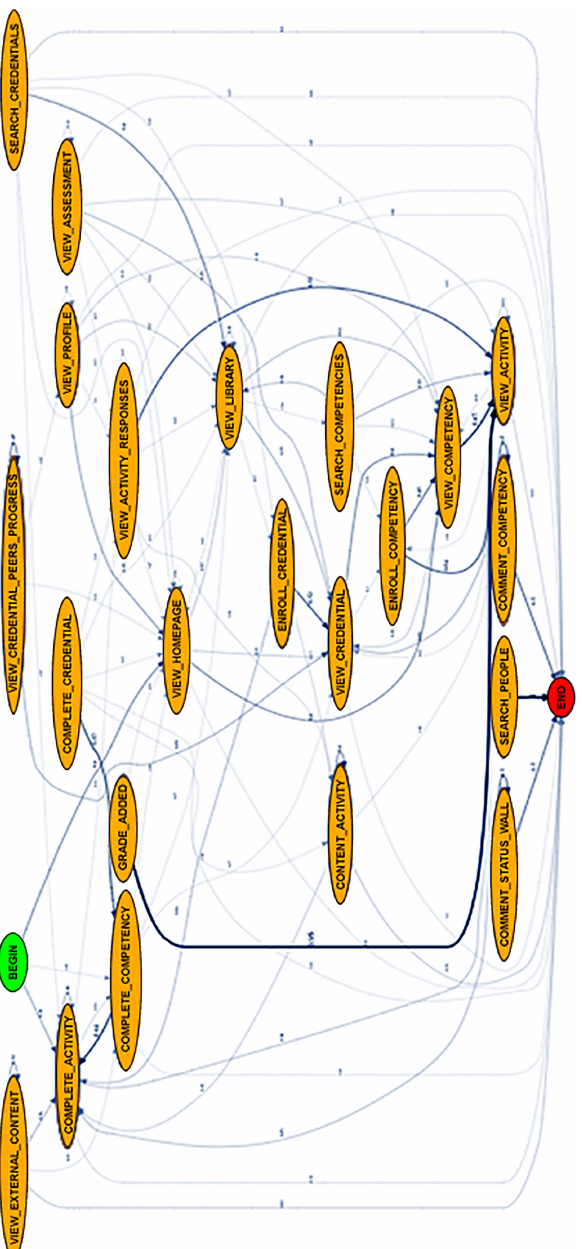
Figure 1. Process model for